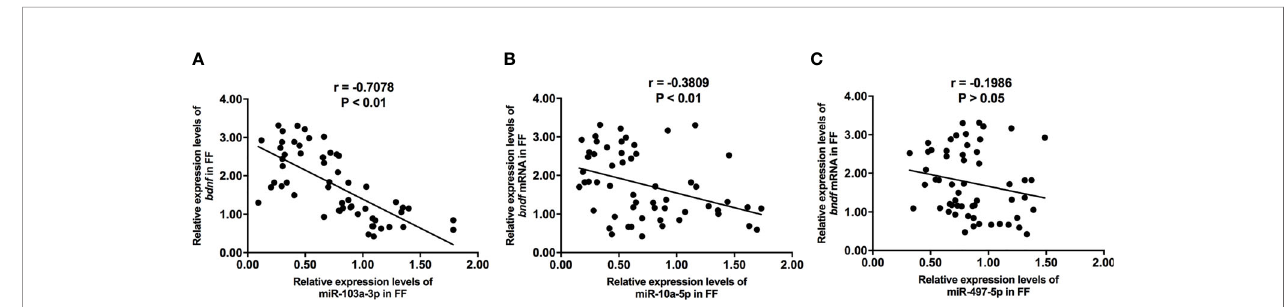
FIGURE 3 | The correlations of miR-103a-3p (A) , miR-10a-5p (B) and miR-497-5p (C) expression with bdnf expression in FF from mature (>18 mm) and immature (<15 mm) follicles. Pearson coef fi cient was used to assess the correlation.